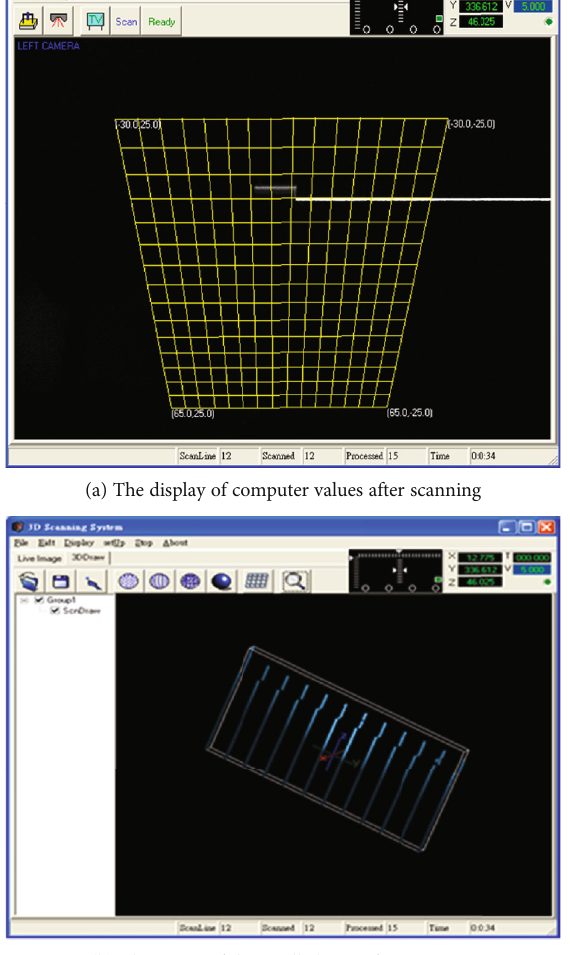
(b) The image of thin-walled part after scanning Figure 8: Convert optical measurement to computer numerical